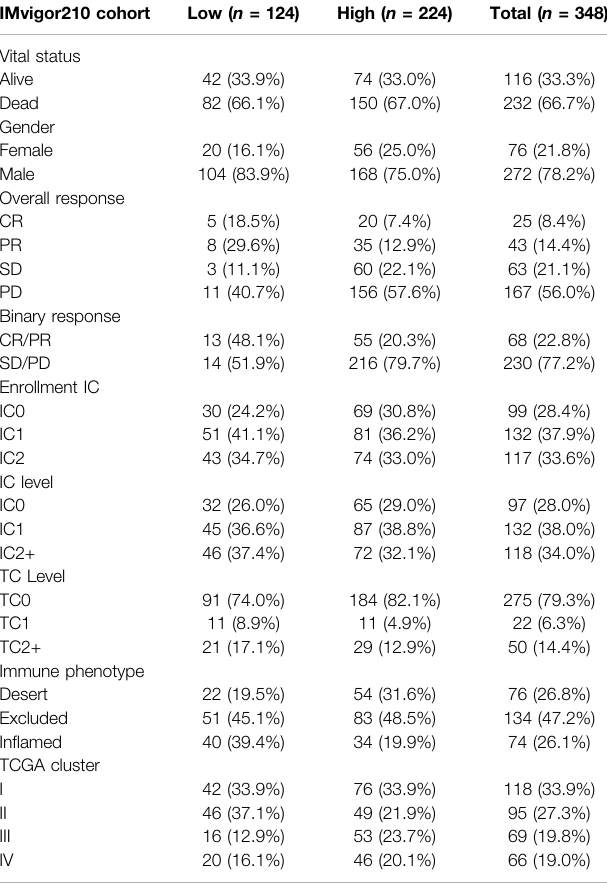
TABLE 2 | Summary of detailed clinical information of IMvigor210 (mUC) cohort. IMvigor210